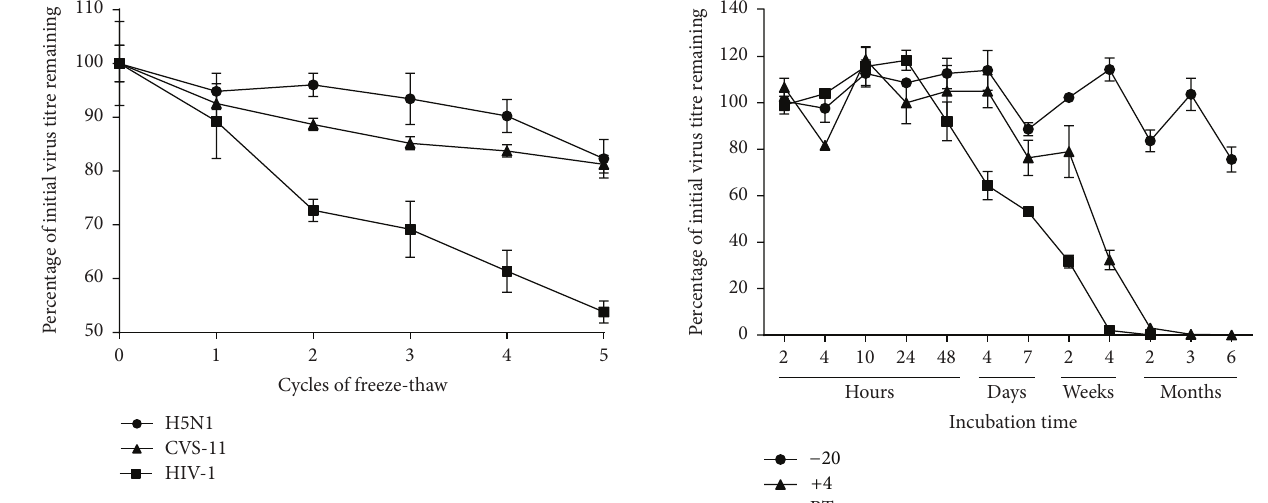
Figure 2: The influence of freeze-thaw cycles on pseudotype virus titre. The stability of H5N1 lacZ pseudotypes was evaluated by subjecting aliquots of virus to 5 cycles of freeze-thaw. Results for pseudotypes bearing the rabies virus (CVS-11) and HIV-1 envelope proteins are shown for comparison. One biological replicate of each pseudotype virus was used to generate three technical replicates. Error bars represent standard deviation.